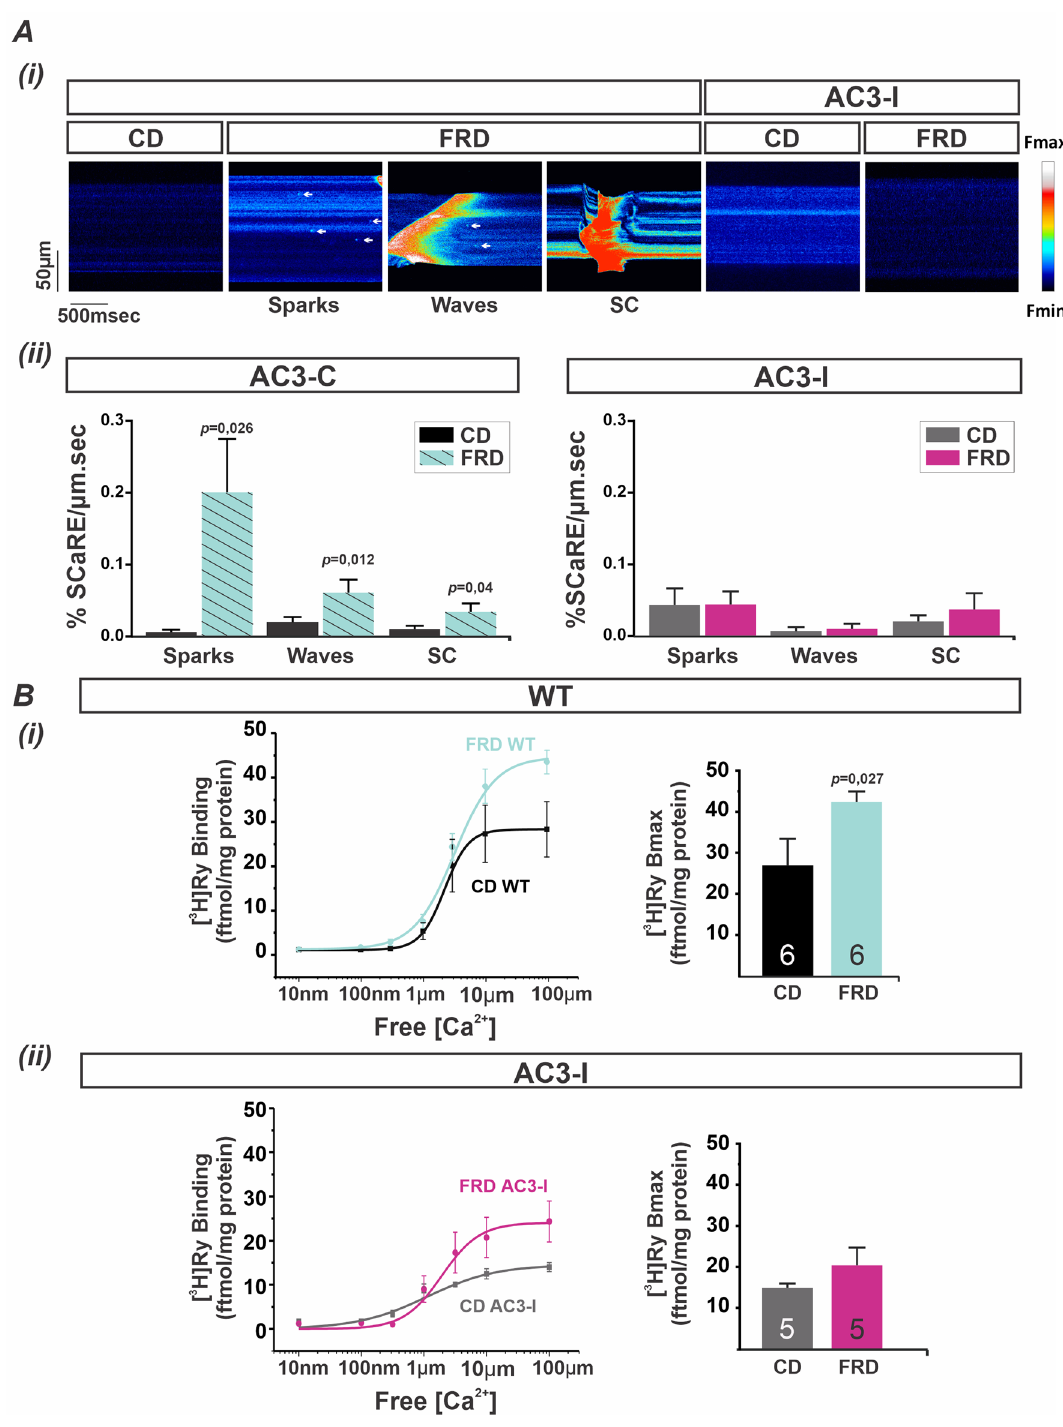
Figure 1. CaMKII-dependent RyR2 hyperactivity increases SR-Ca 2+ leak in prediabetic mouse hearts. ( A ) (i) Representative confocal line scan images from CD and FRD AC3-C and AC3-I mouse cardiomyocytes showing sparks (white arrows), waves, and spontaneous contraction (SC), in FRD AC3-C mice. These spontaneous events are absent in CD WT and in CD and FRD AC3-I myocytes. ( ii ) Frequency of Spontaneous Ca 2+ Release Events (SCaRE) in AC3-C and AC3-I mice. Mean ± SEM, n=10-13 cardiomyocytes from 3 mice per group. ( B ) Average [ 3 H]Ryanodine binding curves fitted by Hill equation (left) and Bmax mean bar graph (right) from ( i ) CD and FRD WT mice and ( ii ) CD and FRD AC3-I mice heart homogenates. Only FRD WT mice present a significant increase in RyR2 maximal